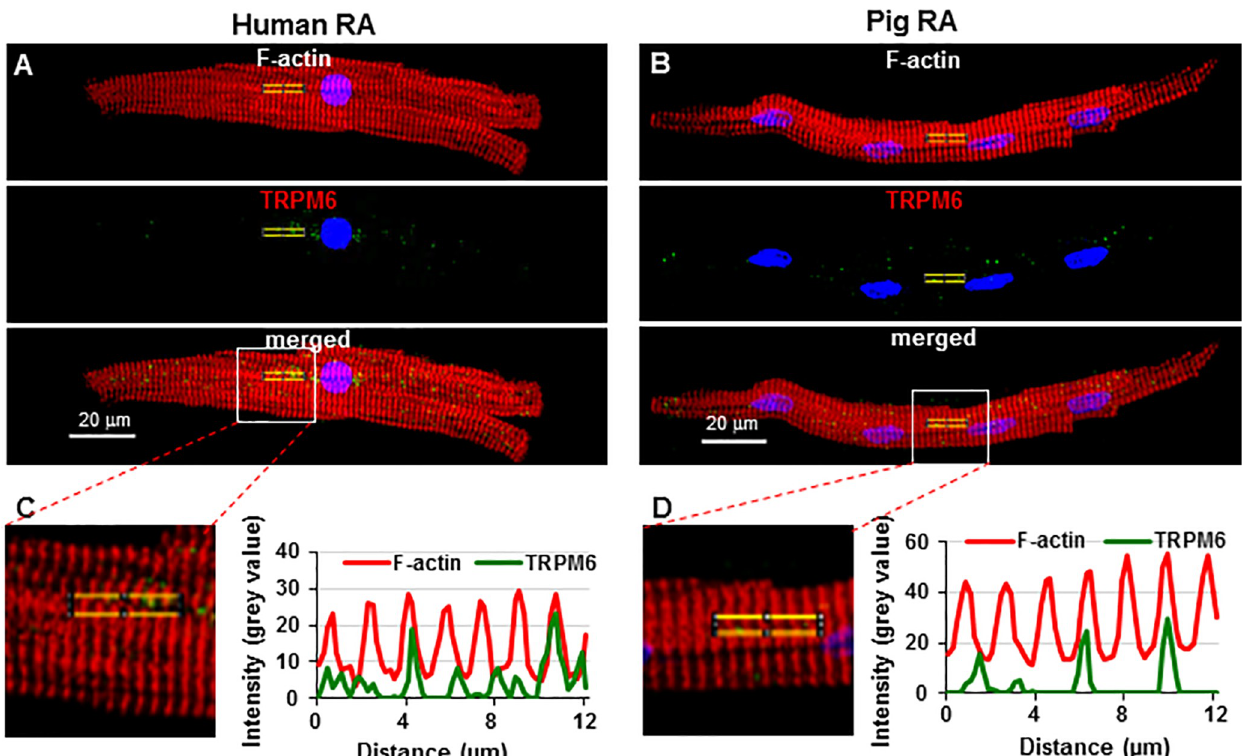
Figure 3. Cellular localization of TRPM6: ( A , B ) The immunofluorescence images of TRPM6 (stained in green when using Alexa Fluor 488) and F-actin cytoskeleton (stained in red when using Phalloidin- Alexa Fluor 546) were used for calculating fluorescence intensity in human ( A ) and porcine ( B ) RA cardiomyocytes presented in ( C , D ). Hoechst 33342 for nuclei appears in blue. Scale bars indicate 20 µ m; ( C , D ) constructed graphs of the fluorescence intensity for the localization of TRPM6 (green) and F-actin (red) along lines of interest on the merged images of cardiomyocytes as indicated by the zoomed-in area. The calculated correlation coefficient between F-actin and TRPM6 peaks (at a place as indicated) was 0.25 for human ( C ) and 0.33 for pig ( D ) RA